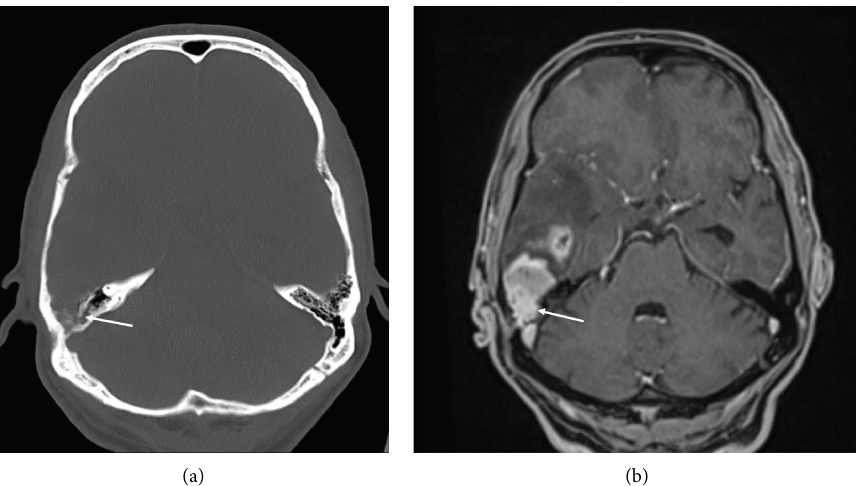
Figure 1: Axial plain CT (a) and contrast-enhanced MRI (b) at the level of the petrous ridges. (a) CTvisualizes the osseous destruction of the right petrous ridge (arrow). (b) Contrast-enhanced T1-weighted MRI discloses infltration of the GBM into the mastoid cells of the right temporal bone (arrow).